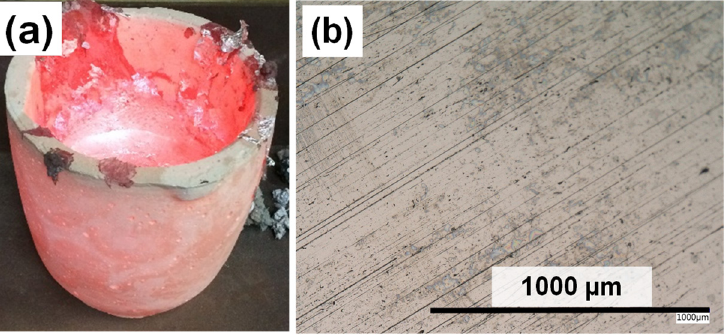
Figure 11. ( a ) A picture of the hot crucible used in the ALCAN immersion test (with size on a reduced scale); and ( b ) an optical image of the Mo-block surface after cleaning with HCl. Table 3. Sample materials indicating mass loss (20%) after the ALCAN immersion test.